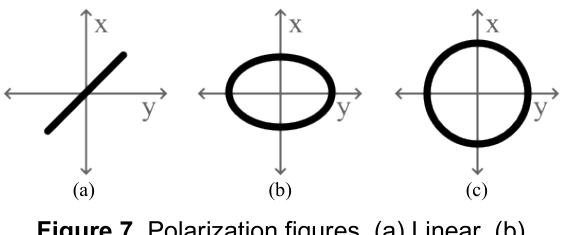
Figure 7. Polarization figures. (a) Linear. (b) Elliptical. (c)